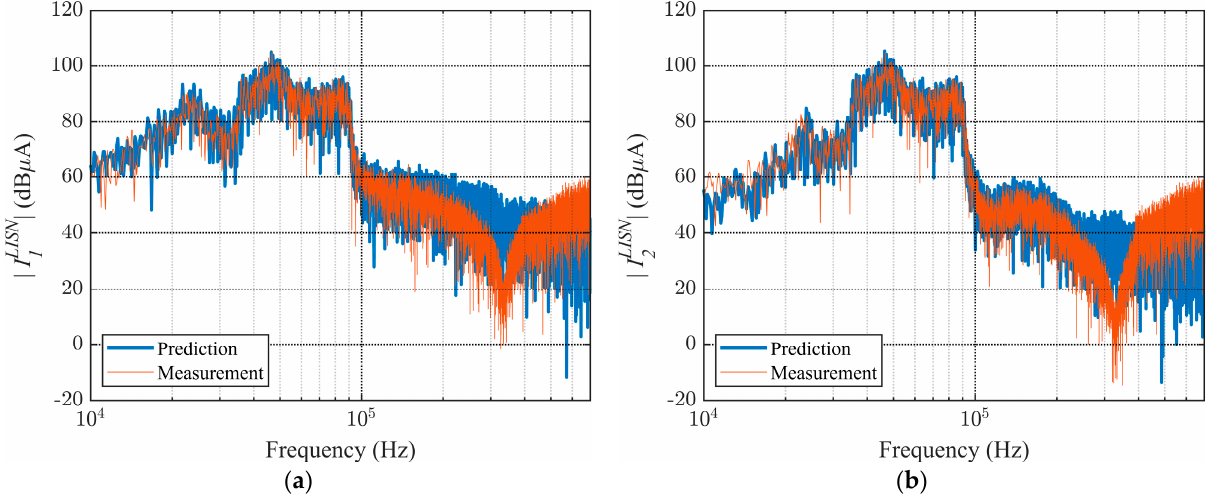
Figure 13. Currents ( a ) I LISN and ( b ) I LISN obtained from the prediction model and measurement 1 2 data in test case #1 (with LISN B1). The PLC Tx modem is represented according to Section 3.